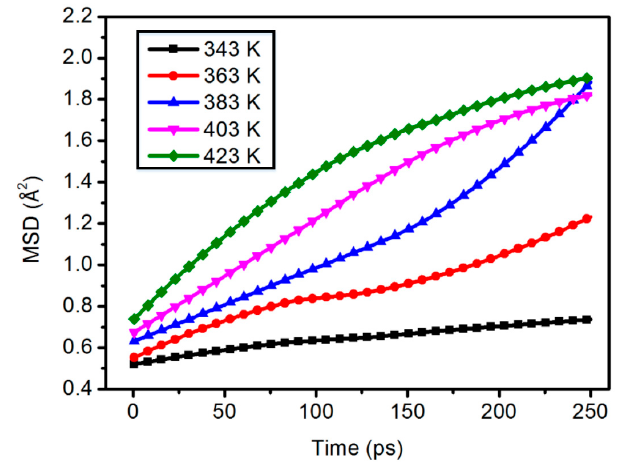
Figure 5. Chain motion of the 0 wt % content composite model.